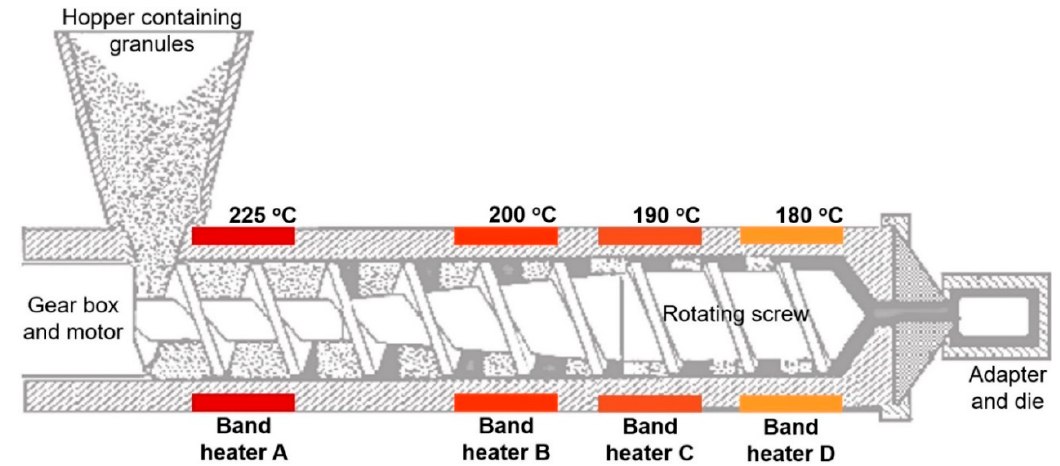
Figure 8. Schematic of extruder with heating temperatures used in this work.